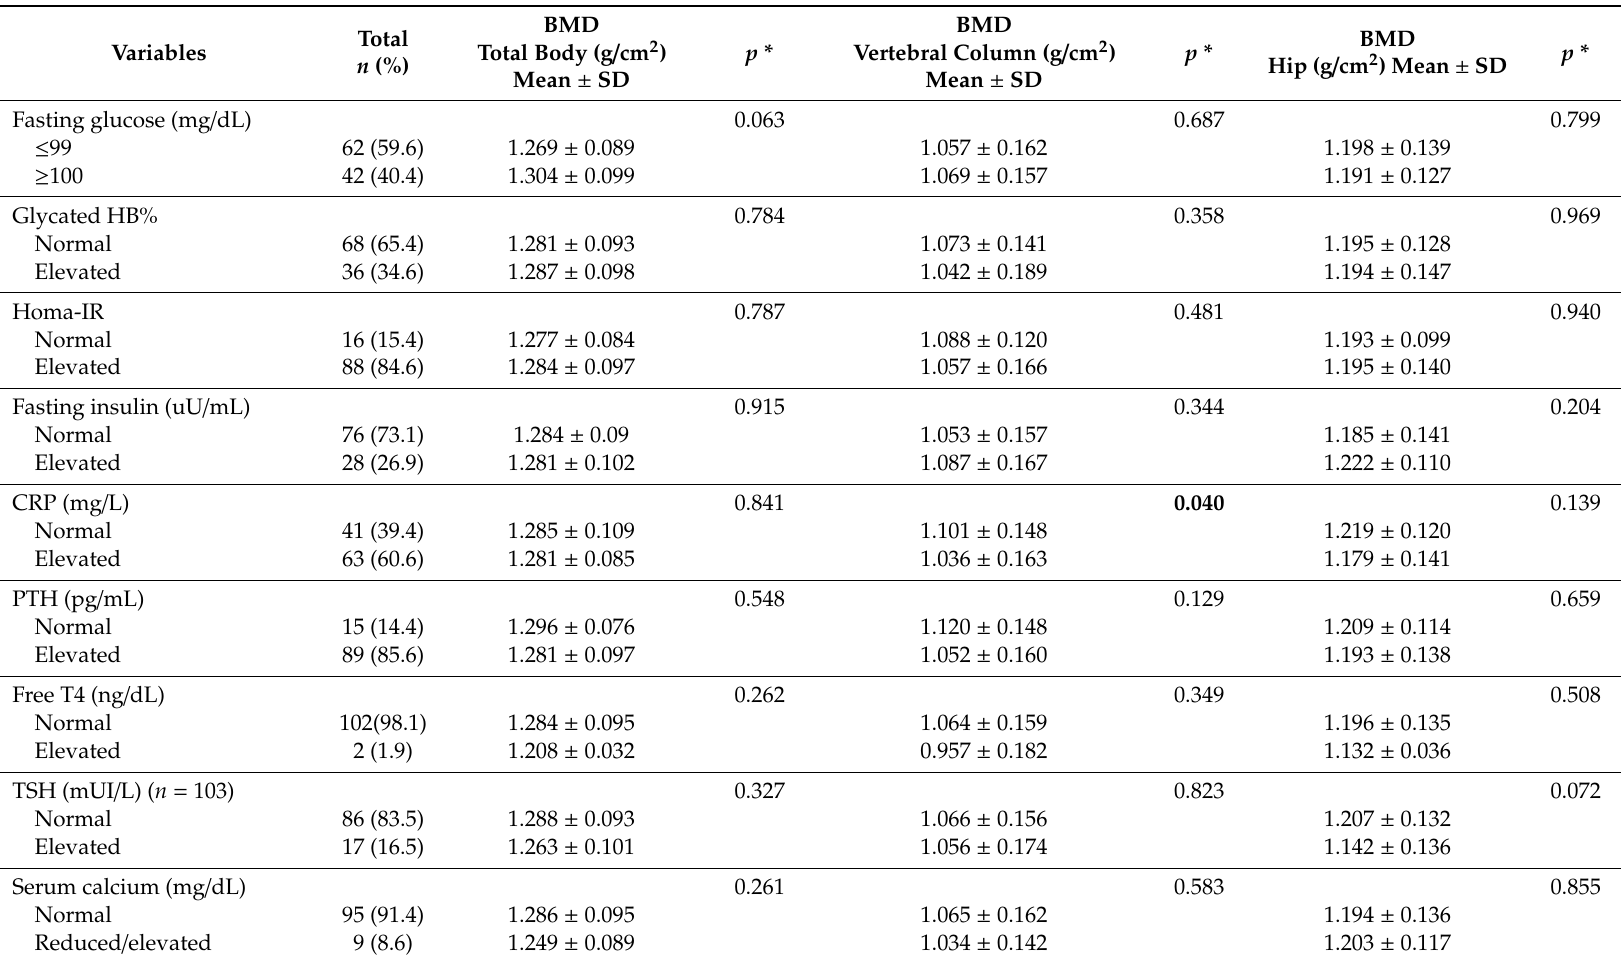
Table 3. Associations between bone mineral density in three sites and biochemical tests in severely obese women, DieTBra Trial, 2016 ( n =